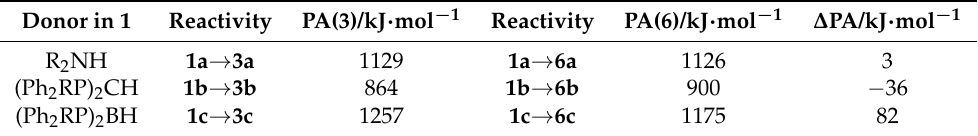
Table 1. Calculated Proton affinities of complexes 3a – 3c and 6a – 6c (G16, B97D/def2-TZVPP).